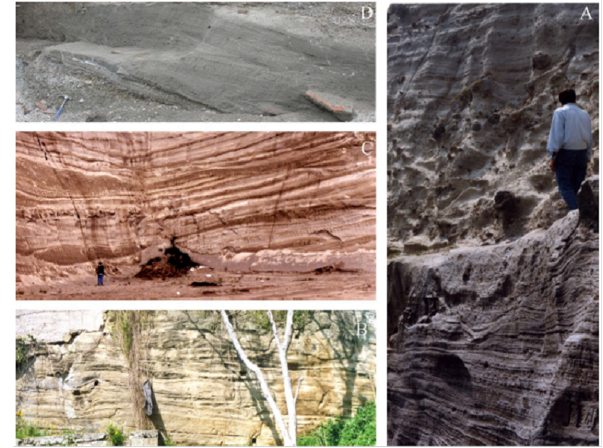
Fig. 6. Stratified deposits: (A) Trentaremi Tuff showing abundant cross-stratification and sand-wave structures; (B) panoramic view of the Capodimonte Tuff, with undulating thin ash and fine lapilli layers; (C) section through the Neapolitan Yellow Tuff. Note the complex multilayered nature of this deposit; (D) sedimentary struc- tures in the AD79 deposit in the ancient town of Pompeii. Frag- ments of tiles and walls are present in the